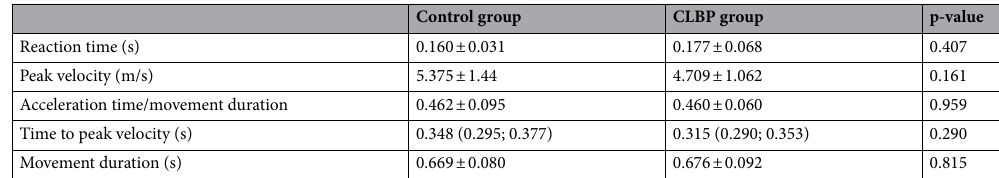
Table 2. Comparison between kinematic parameters. Data expressed as mean ± SD if presented with a normal distribution, or median and percentiles if presented with nonparametric